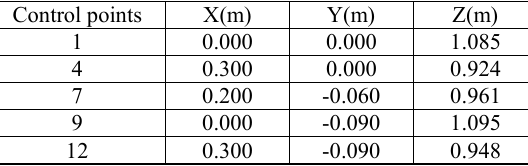
Table 2. The coordinates of the control points